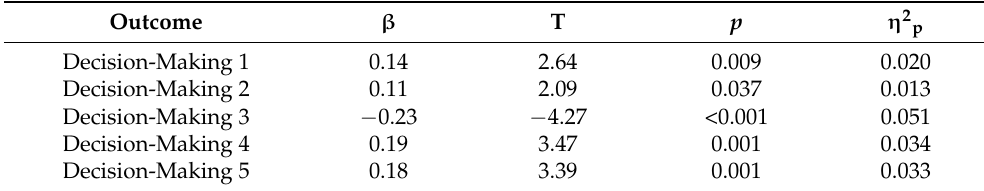
Table 2. Results of the multivariate regression with goal conflicts as predictor and risky decision making as outcome variables.